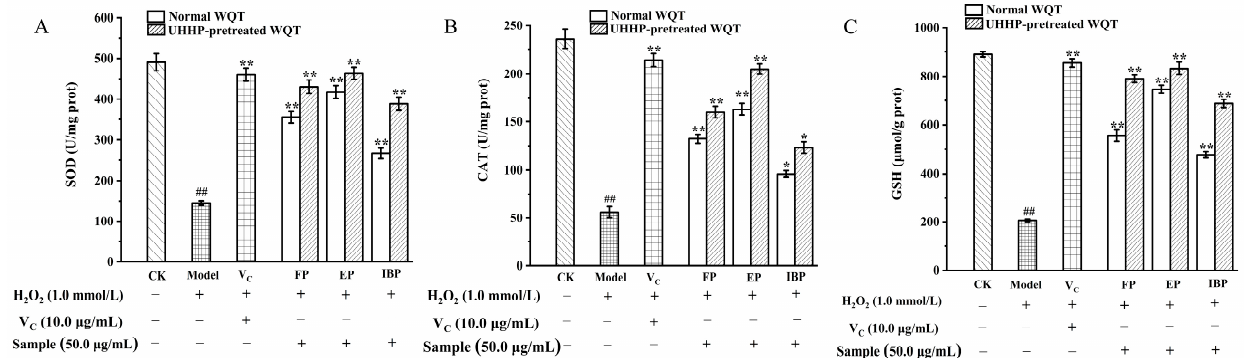
Figure 3. The effects of the free, esterified, and insoluble-bound phenolic fractions from the normal and UHHP-pretreated White Que Zui tea (WQT) on SOD ( A ), CAT ( B ), and GSH ( C ) expressions. * p < 0.05 compared to the model group; ** p < 0.01 compared to the model group; ## p < 0.01 compared to the control group. All the values are expressed as mean ± SD (n = 3). FP and UFP: free phenolic fraction from normal and UHHP-pretreated WQT; EP and UEP: esterified phenolic fraction from normal and UHHP-pretreated WQT; IBP and UIBP: insoluble-bound phenolic fraction from normal and UHHP-pretreated WQT.